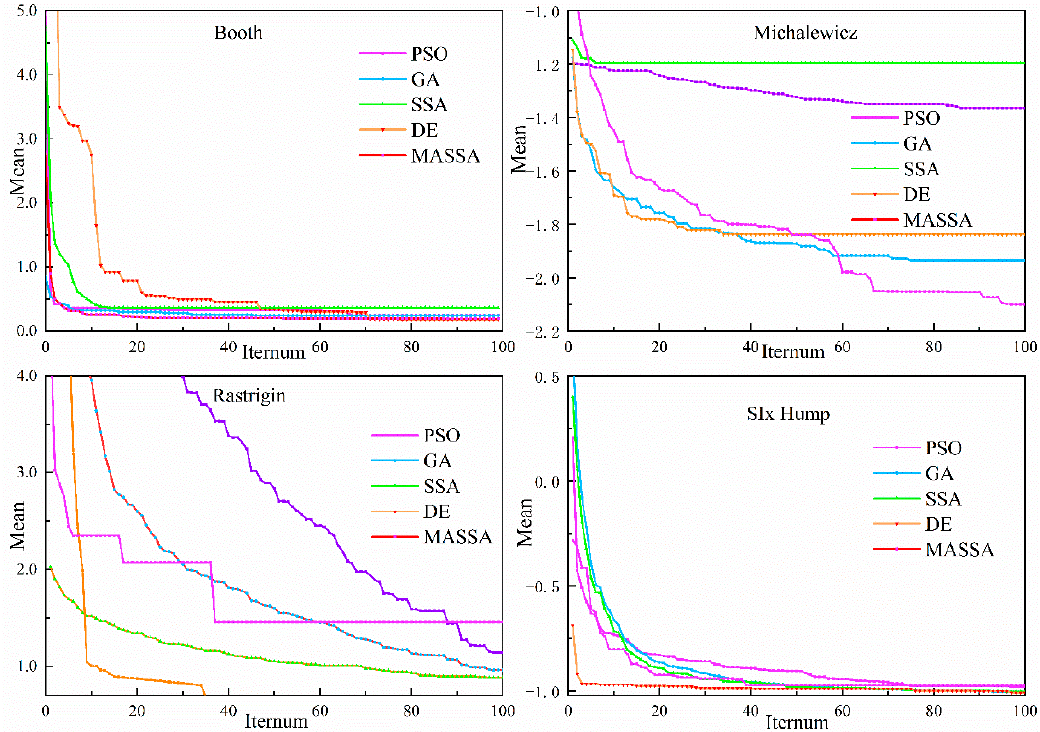
Figure 5. Convergence results 1 of multimodal benchmark functions.